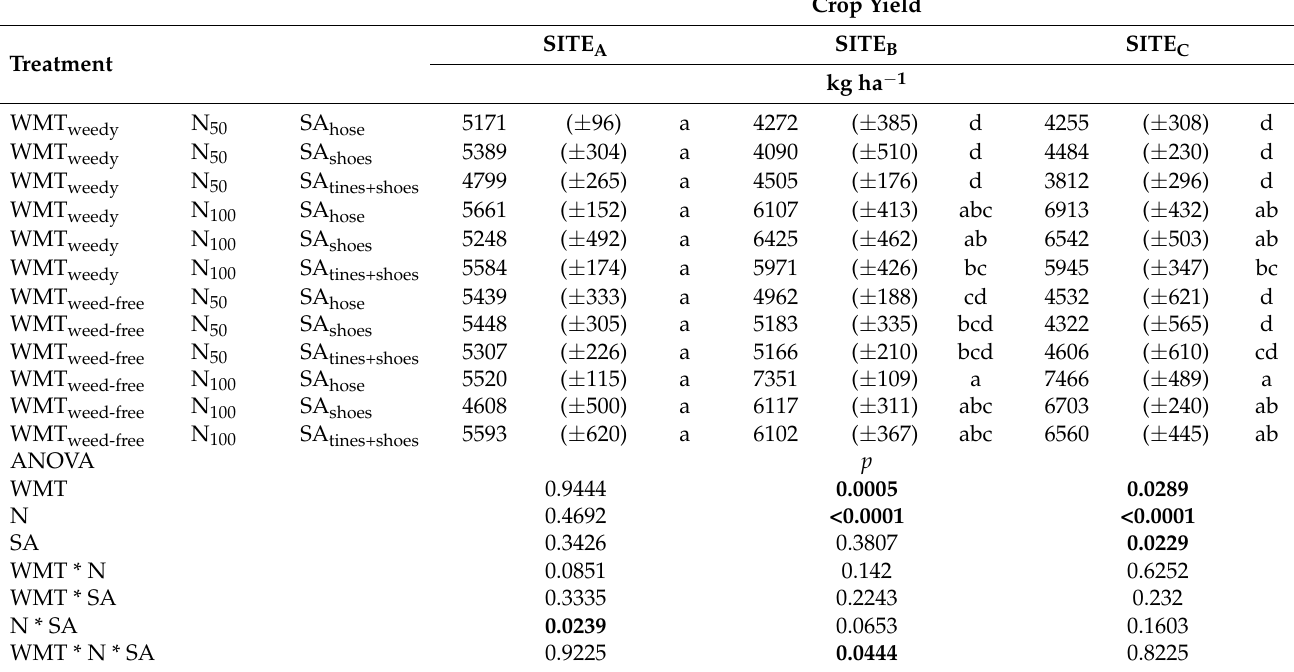
Table 3. The effect of weed management treatment (WMT weedy and WMT weed-free ), nitrogen rate (N 100 and N 50 ), and slurry application method (SA hose , SA shoes , and SA tines+shoes ) on spring barley grain yield (SITE A ) and winter wheat grain yield (SITE B and SITE C ), presented at 15% moisture content. Data from each site were analyzed separately. A connecting letters report displays differences among treatments, whereby means not sharing a similar letter are significantly different ( p < 0.05). Significant main effects and interactions are highlighted in bold text ( p < 0.05). Standard errors are displayed in